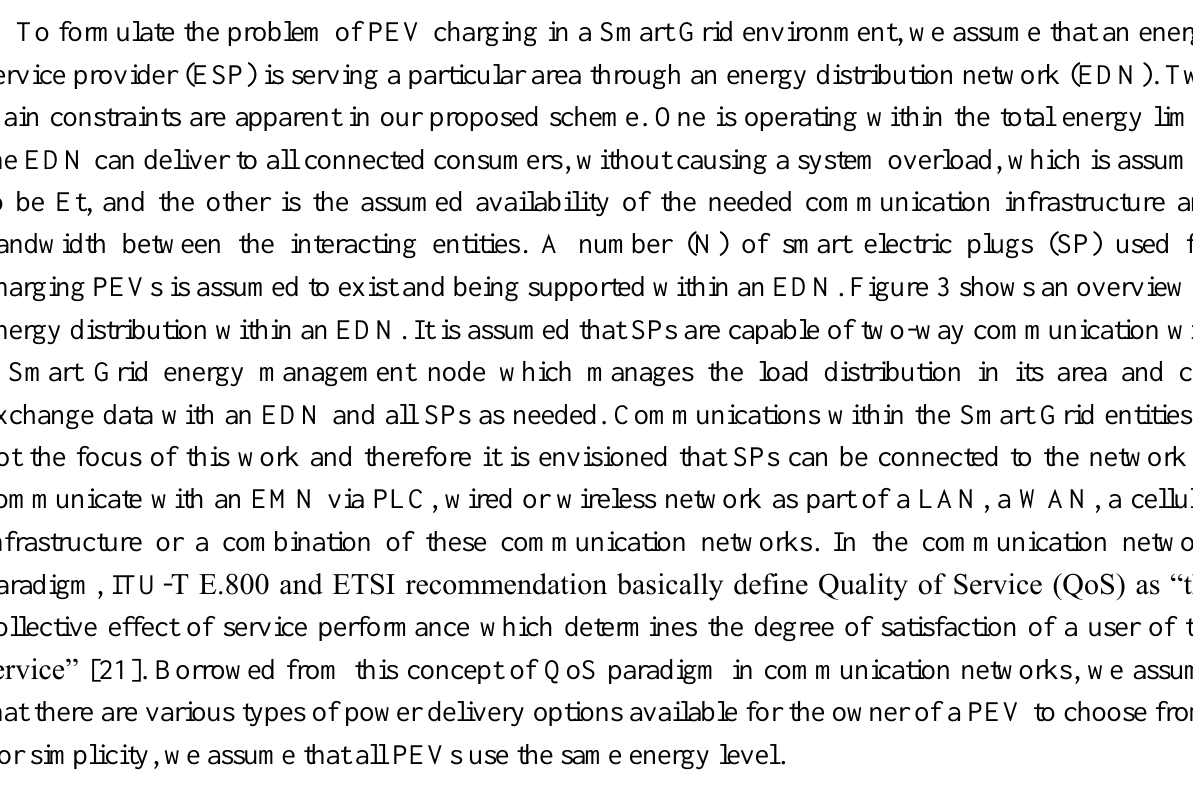
Figure 3. High level energy distribution